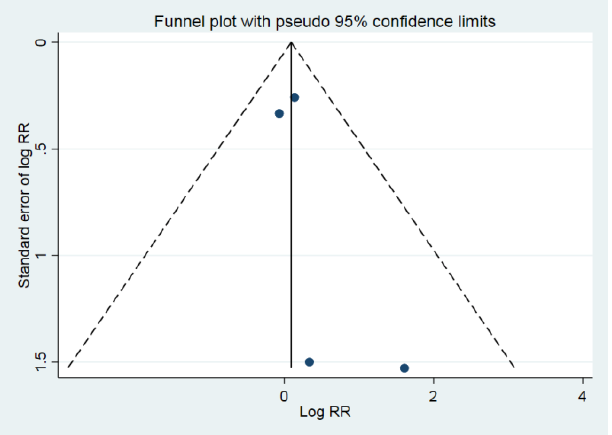
Figure 4. The funnel plot of included studies for publication bias. RR, relative risk.